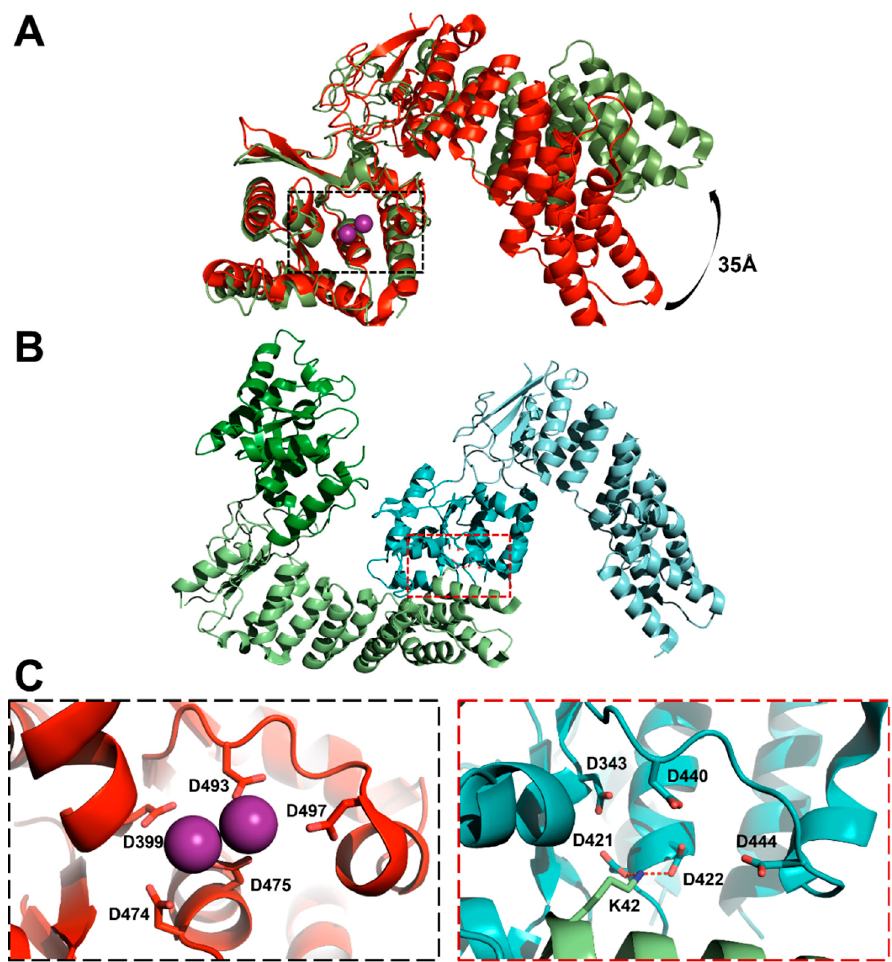
Figure 5. Crystal structures of At PRORP1 (PDB 4g24) and At PRORP2 (PDB 5diz) [64,103]. ( A ) Three ‐ dimensional alignment of At PRORP1 and At PRORP2 structures via their active sites (dashed box). PRORP1 (red) topology includes the NYN metallonuclease domain bound to Mn 2+ (purple spheres). PRORP2 (green) is in a more “open” conformation, resulting in a ~35 Å difference in the position of the first PPR helix; ( B ) At PRORP2 crystallization dimer (left), with subunits labeled in green and cyan (NYN domains in brighter colors); ( C ) Expanded views of the dashed boxes in panel A (left) or B (right). The At PRORP1 active site (left) includes four fully ‐ conserved aspartates and one partially ‐ conserved aspartate (sticks). Close ‐ up of intersubunit interaction (right) between At PRORP2 molecules, with active site aspartates of one molecule interacting with Lys 42 (sticks) of the second (red dashed lines).